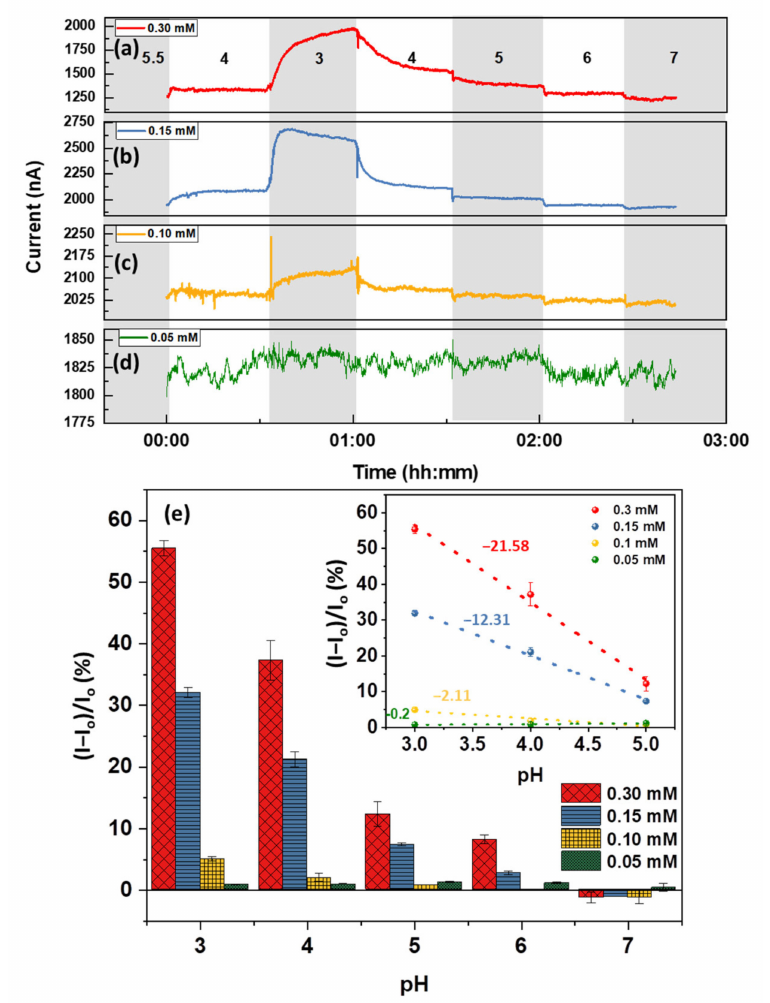
Figure 4. Sensing performance of 8 h annealed FLG functionalized by ( a ) 0.3 mM (I o = 1274 nA), ( e ) the calibration bar graph of the sensors demonstrating the highest pH response at around -COOH pK a (3.1). The error bars represent average ± standard deviation of the last two minutes of the chemiresistive response (3 samples